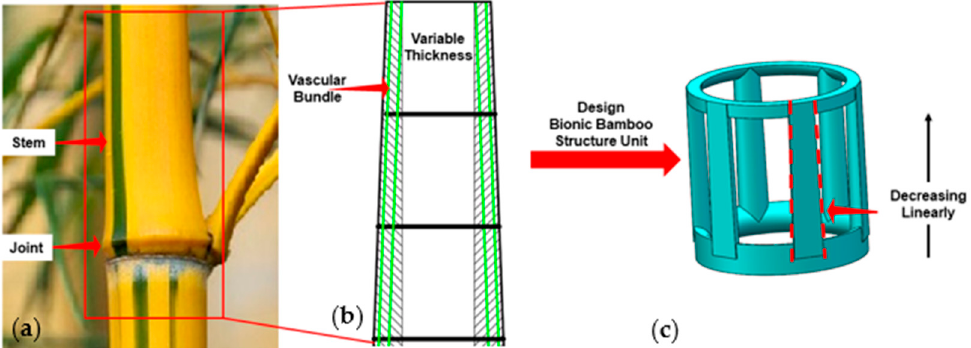
Figure 1. Bionic design inspired by bamboo. ( a ) bamboo in nature, ( b ) longitudinal section, ( c ) bionic bamboo lattice unit.